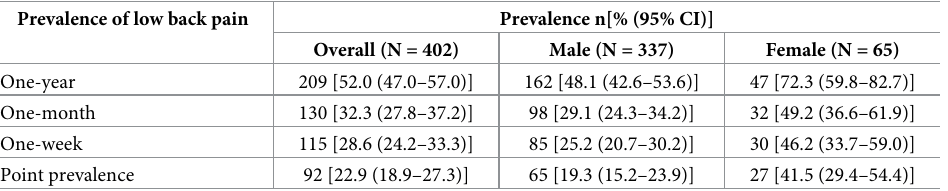
Table 2. Prevalence of low back pain among construction workers (N =